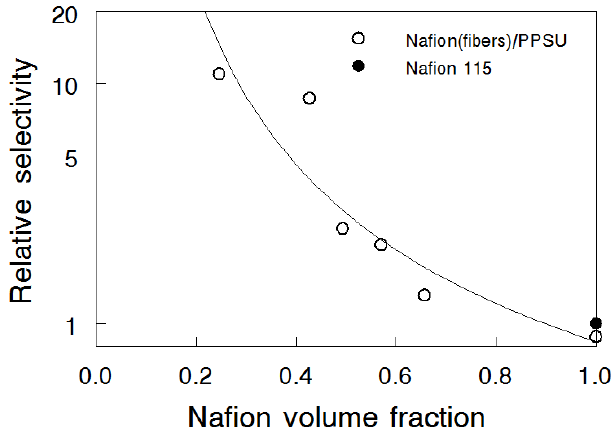
Figure 7. Relative, with respect to Nafion 115, selectivity of the nanofiber composite membranes as a function of Nafion volume fractions at 25 °C. ( ○ ) N(fibers)/PPSU; ( ● ) Nafion ® 115.